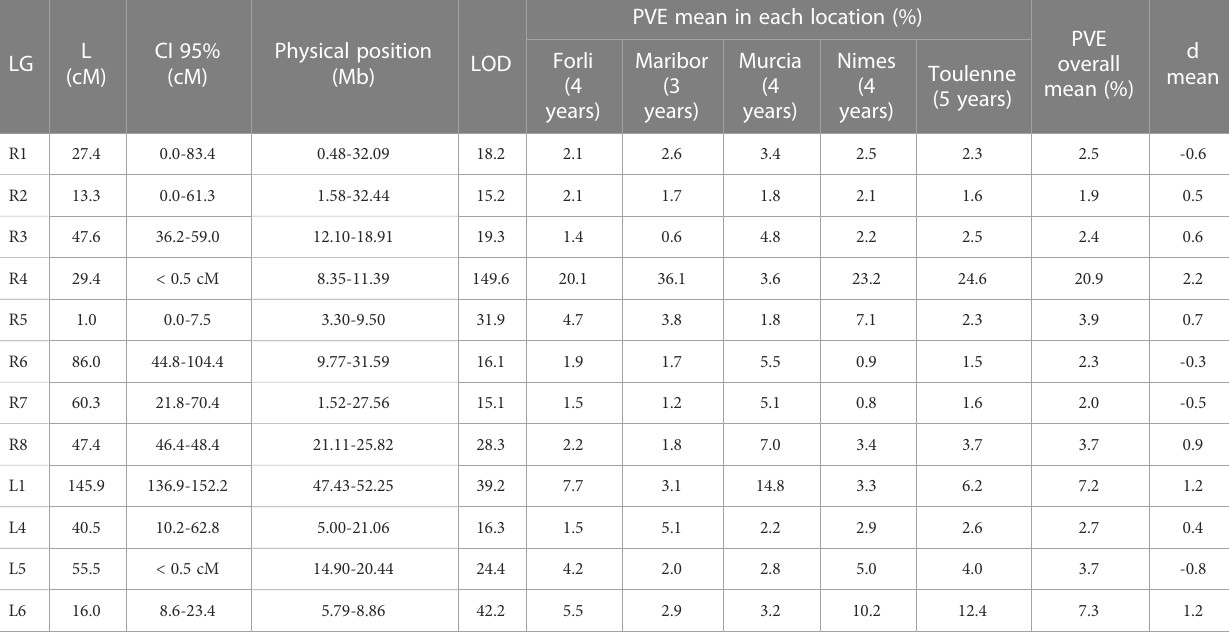
TABLE 2 Beginning of fl owering (BF) QTLs detected with the multi-location — multi-year analysis using altogether the twenty environments of the